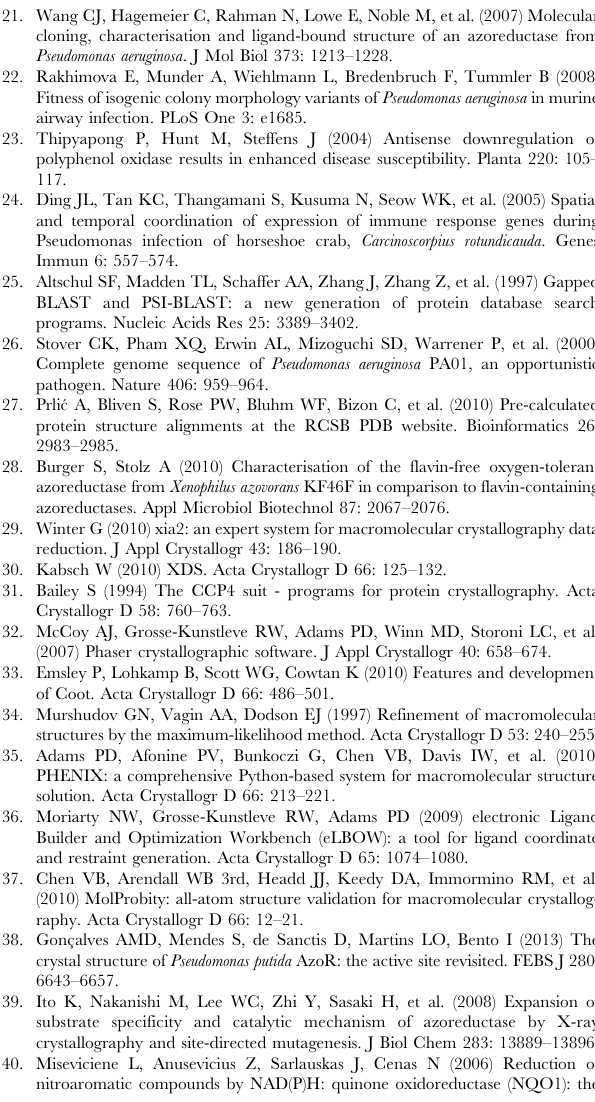
measurements with error bars representing 6 standard deviation from three replicates. Data is taken from [15]. Figure S3 Mechanism of AQN reduction by